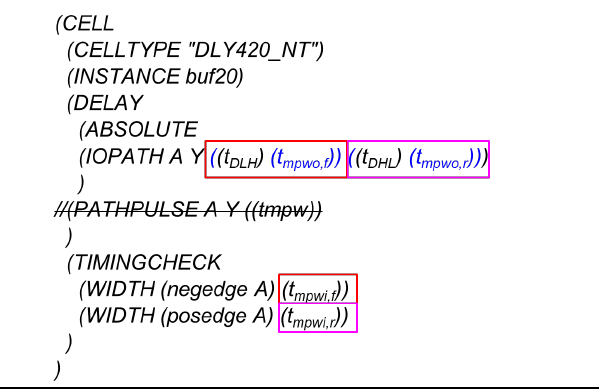
Figure 15. Input SDF from tool implementation flow